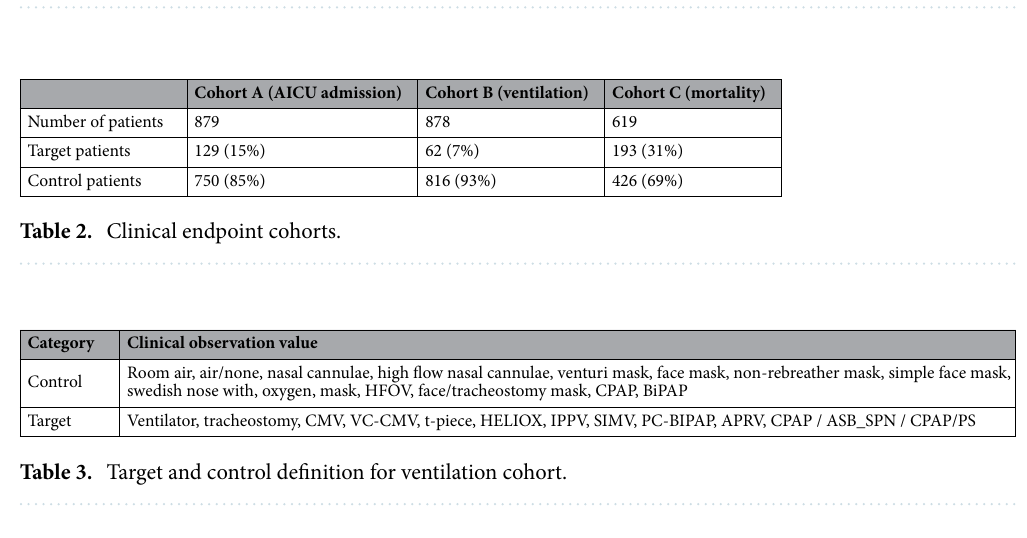
Table 1. Composition of overall patient population.